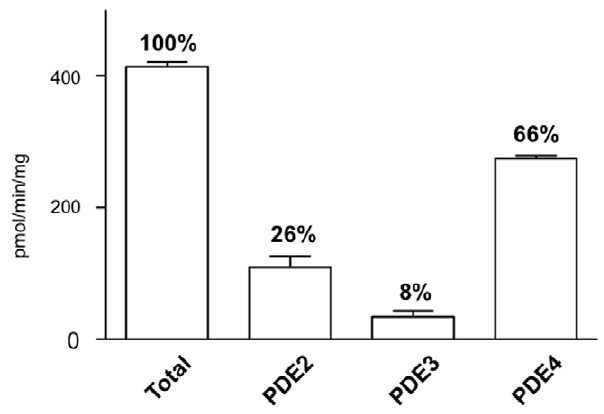
Figure 1. Pattern of cAMP-PDE activities in the kidneys of 8 week-old CBA/J control mice. cAMP-PDE specific activities in total homogenate and contribution of PDE2, PDE3 and PDE4 were assessed as described in the Methods section. Data are expressed as pmol/min/ mg of protein and are the mean 6 s.e.m. of the data obtained from three individual